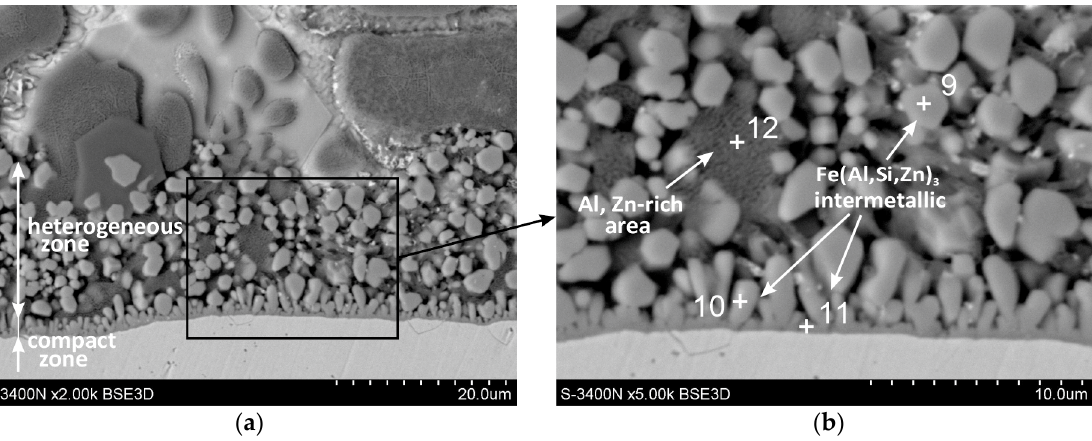
Figure 4. SEM images of the Fe-Al intermetallic layer of the ZAMS coating: ( a ) compact and heterogenous zone of the Fe-Al intermetallic layer and ( b ) analysis points of the EDS of the Fe-Al intermetallic